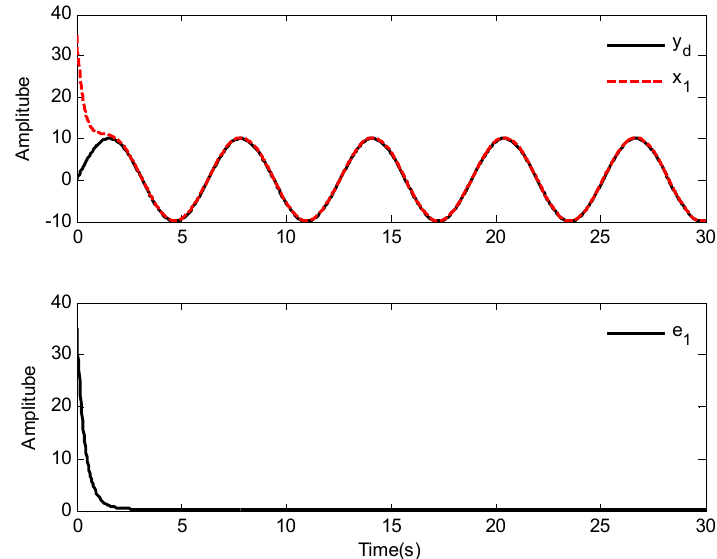
Figure 15. The curves of tracking performance and error.